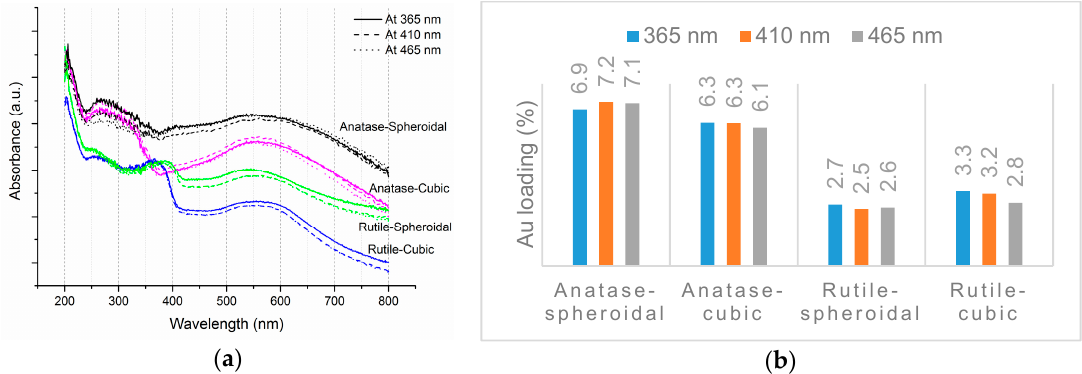
Figure 4. ( a ) UV-VIS spectra and ( b ) EPMA results of Au-TiO 2 .